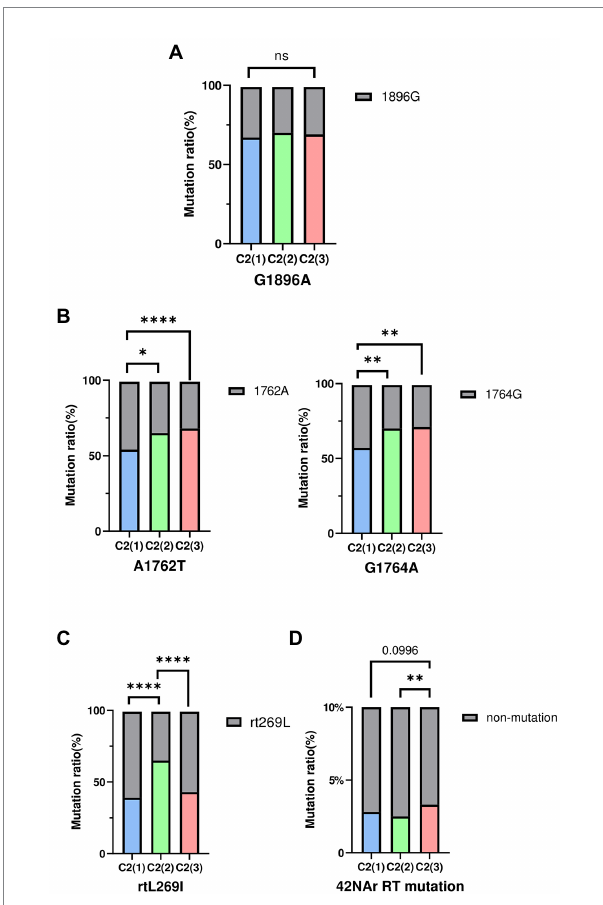
FIGURE 5 The frequency of HBV mutations between three clades. (A) Comparisons of preC/C mutation (G1896A) (B) Comparisons of BCP mutation (A1762T, G1764A). (C) Comparisons of reverse transcriptase polymorphism rtL269I. (D) Comparisons of total 42NAr mutation sites. Categorical variables were tested using the Chi- squared test. ns, nonsignificant, * p < 0.05; ** p < 0.01; *** p < 0.001; **** p <